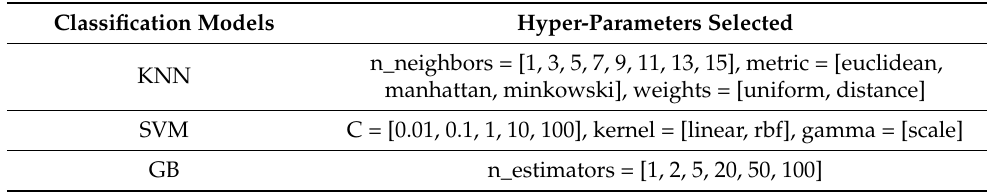
Table 2. The hyper-parameters tested for each